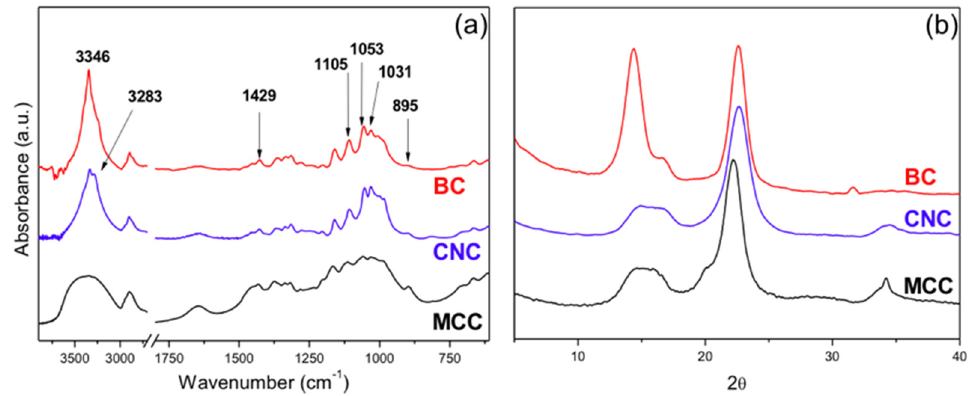
Figure 3. ( a ) FTIR spectra of the two nanocelluloses: BC and CNCs; ( b ) X-ray diffraction spectra of the BC and the CNCs.